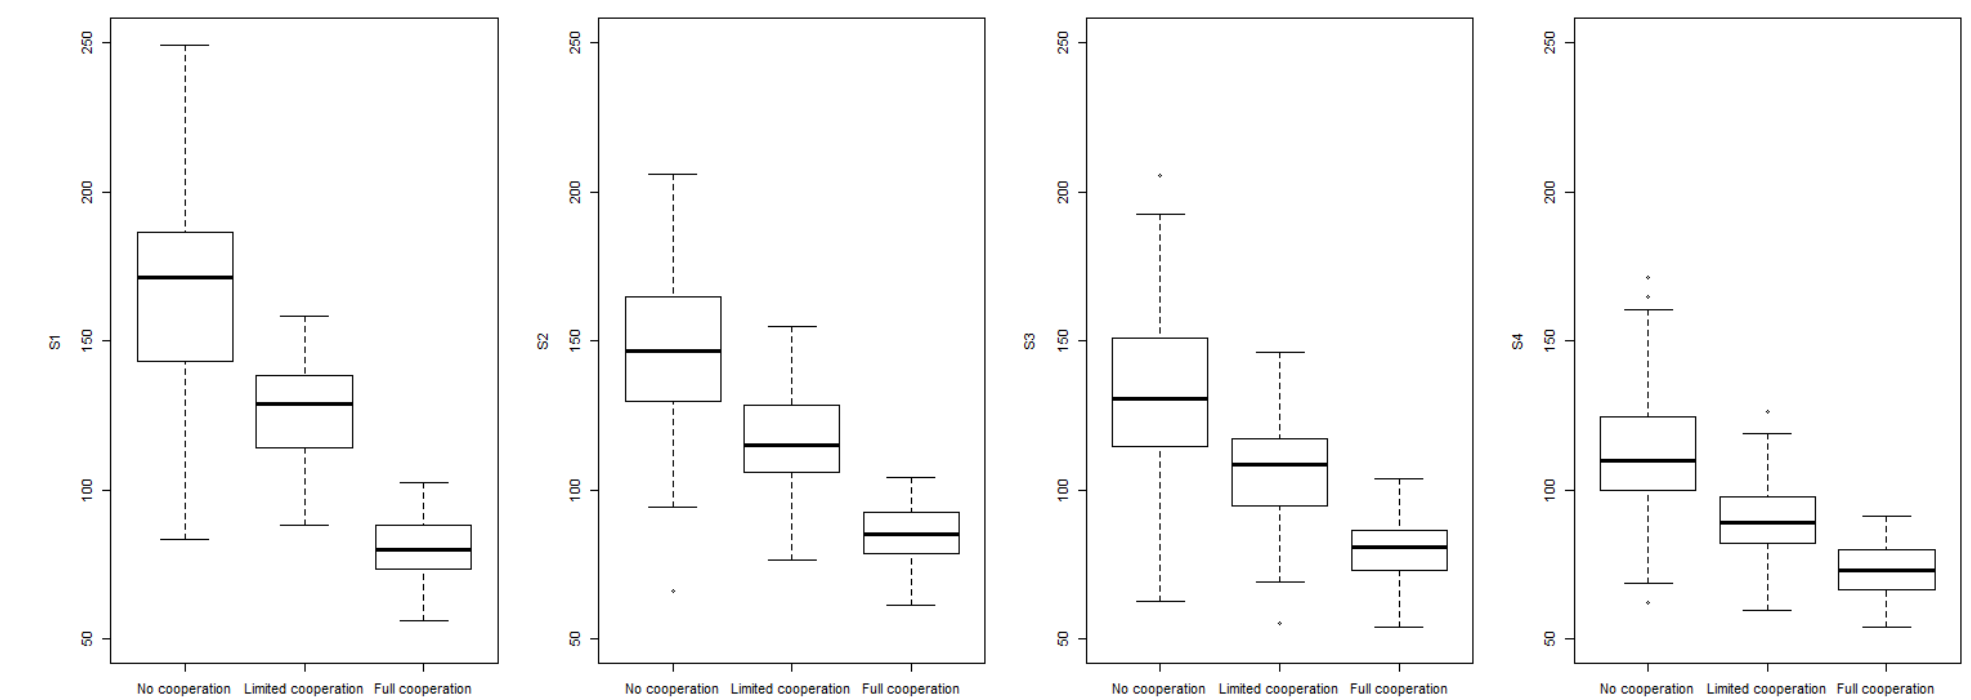
Figure 10. Boxplots for the average lead times in the 100 replications for non-, limited, and full cooperation settings for each